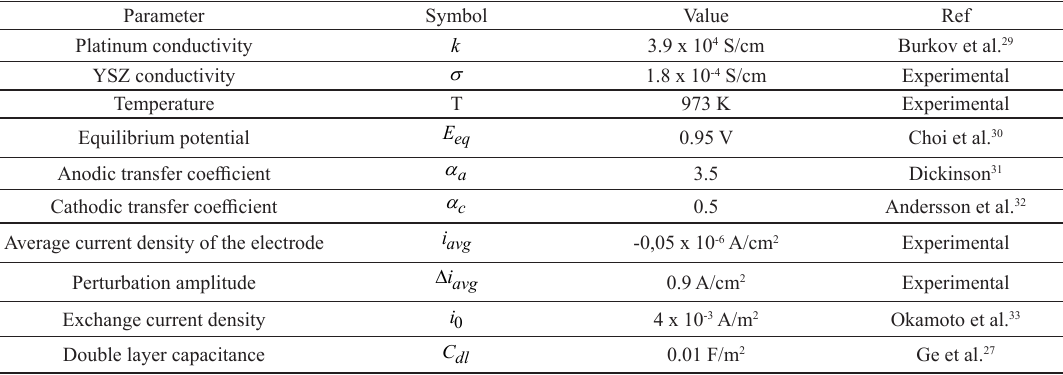
Table 4. Parameters used in the secondary distribution interface.